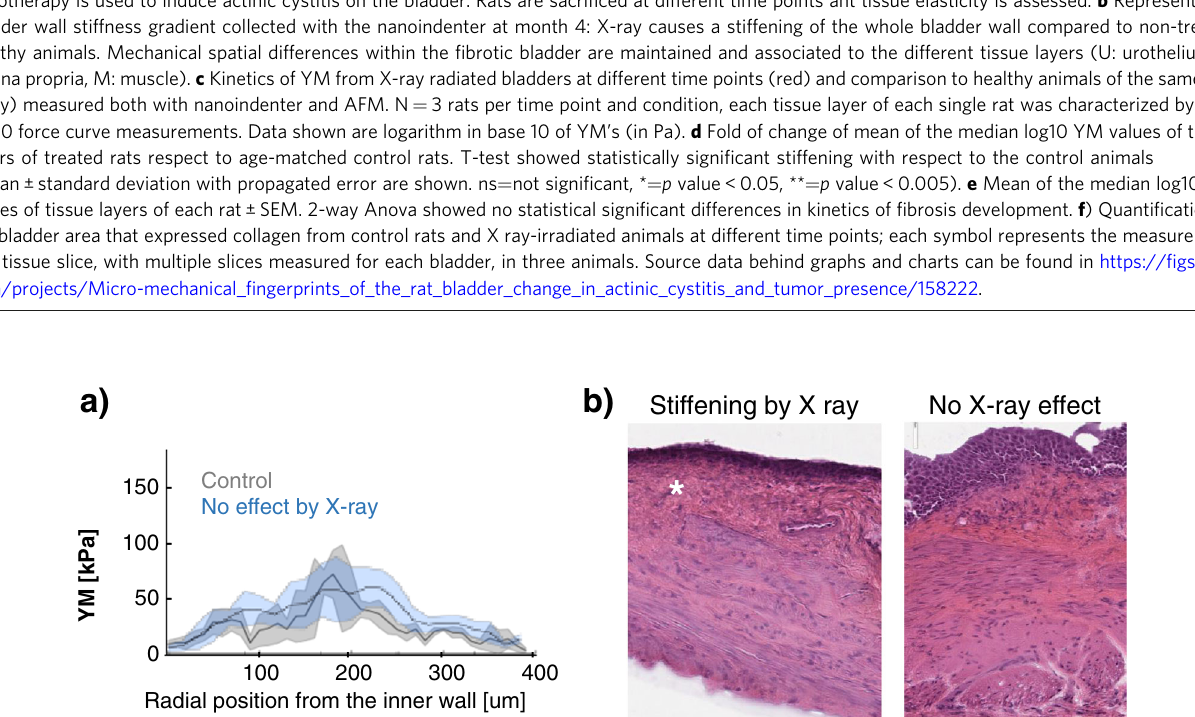
Fig. 3 Animal with no effect by X-ray treatment. a The micromechanical pro fi le (blue) was comparable to those of control healthy tissues of the same age (4 months after irradiation) (grey). b The histological analysis showed denser deposition of ECM (*) in an X-ray-responding animal (left) accompanied by increasing of stiffness. Histology on the bladder with no stiffening (right) revealed absence of fi brotic damage (4 months after irradiation). Source data behind graphs and charts can be found in https:// fi gshare.com/projects/Micro-mechanical_ fi ngerprints_of_the_rat_bladder_change_in_actinic_cystitis_